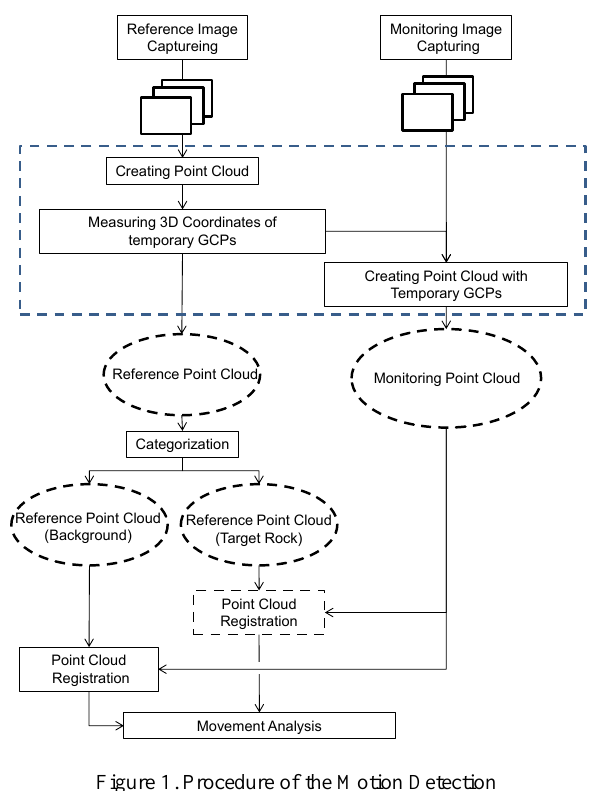
Figure 1. Procedure of the Motion Detection